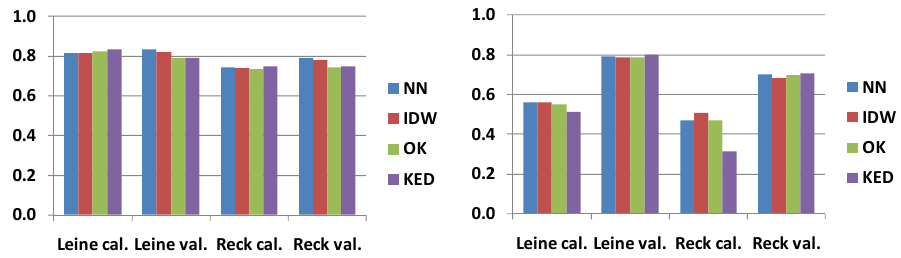
Fig. 3. Results of strategy I, NSE for discharge (left) and nitrate load (right). Gauges Leineturm (Leine) and Reckershausen (Reck) shown for calibration (cal.) and validation (val.) periods.